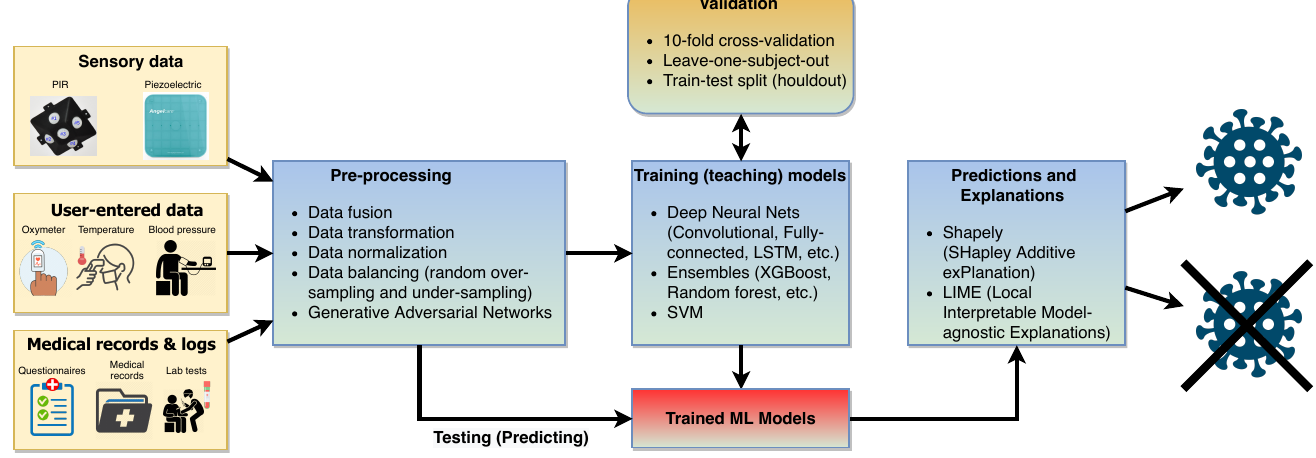
Figure 4. Steps in the machine learning